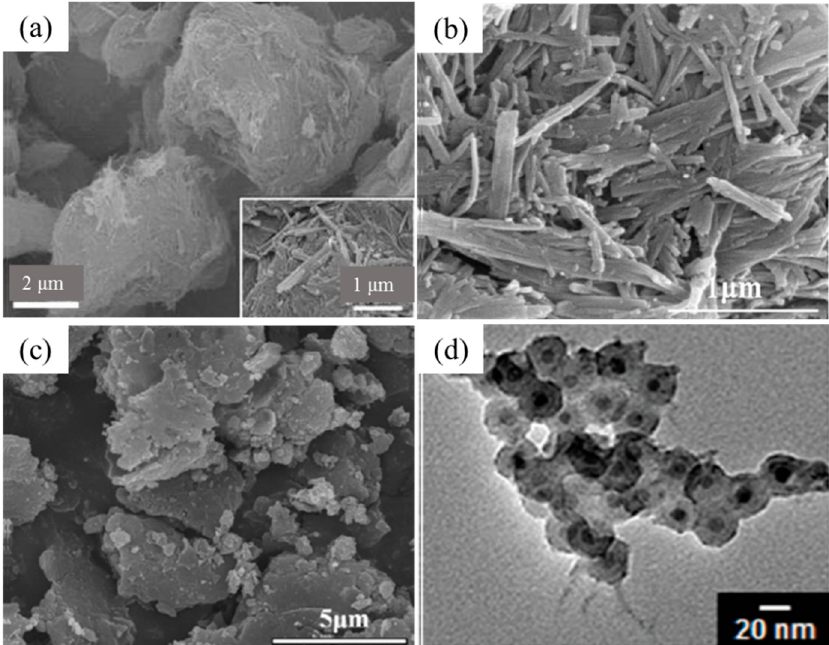
Figure 4. SEM and TEM photos of: ( a ) PANI/ATP, reprinted with permission from [59]. Copyright Elsevier, 2017; ( b ) PANI/SPL, reprinted with permission from [61]. Copyright Elsevier, 2015; ( c ) PANI/laponite, reprinted with permission from [63]. Copyright Elsevier, 2015; and ( d ) Fe 3 O 4 /SiO 2 /PANI nanoparticles, reprinted with permission from [64]. Copyright Royal Society of